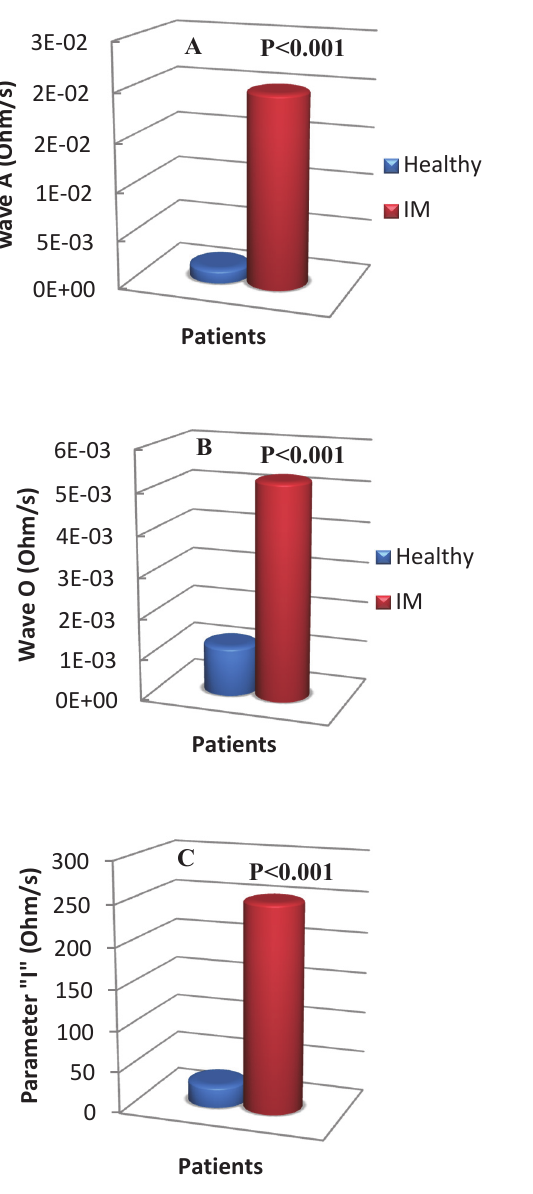
Fig.4: Difference between patients with mitral insufficiency (red) and control subjects (blue): (A) Histogram of the A-wave amplitude, (B) Histogram of the O-wave amplitude, (C) Histogram of the determined parameter “I”.